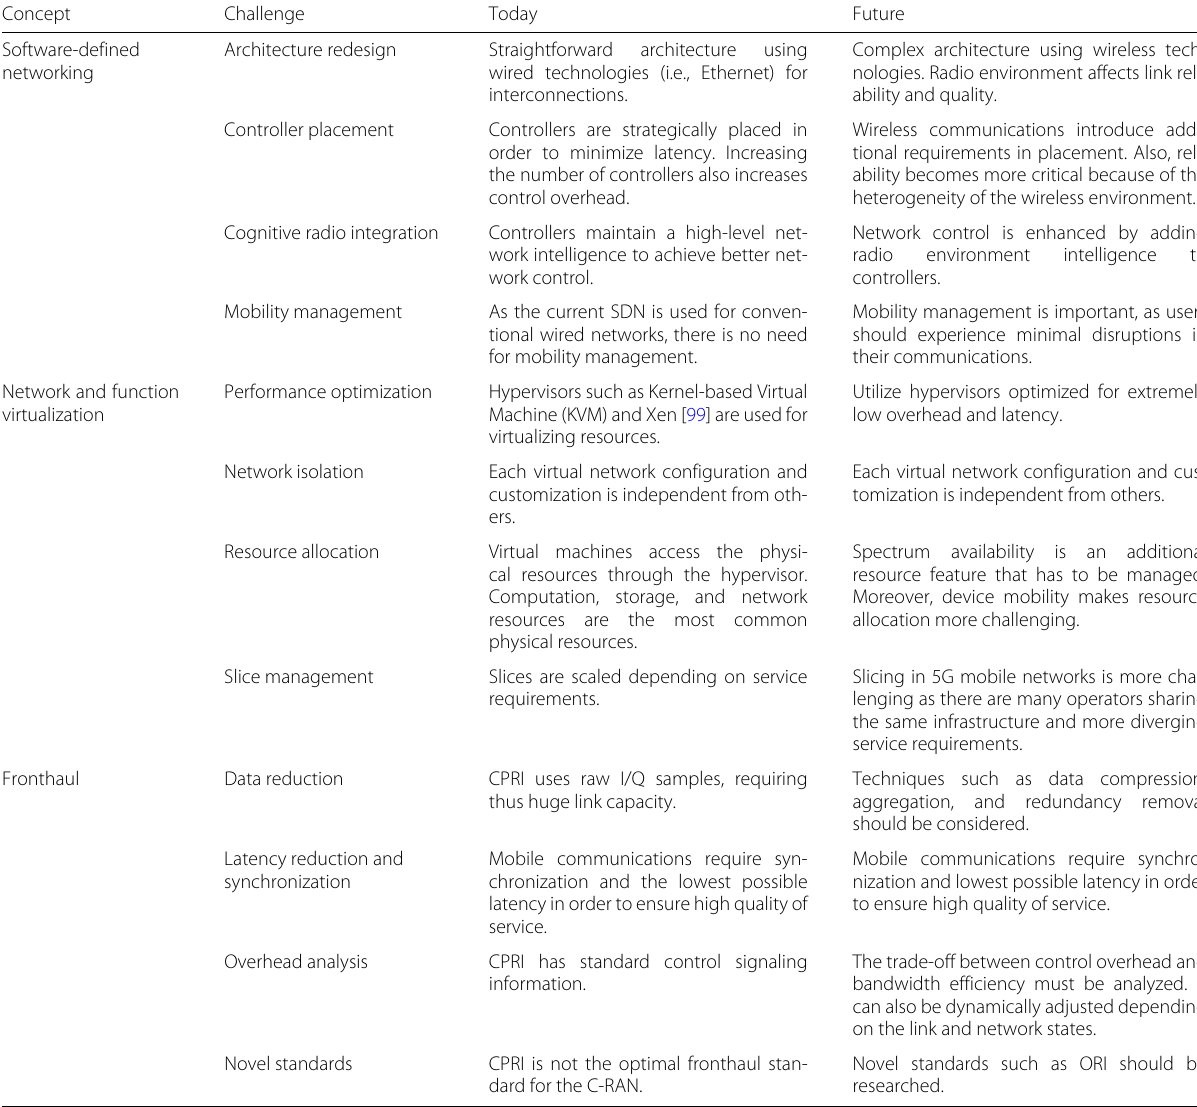
Table 2 Current and future state of C-RAN